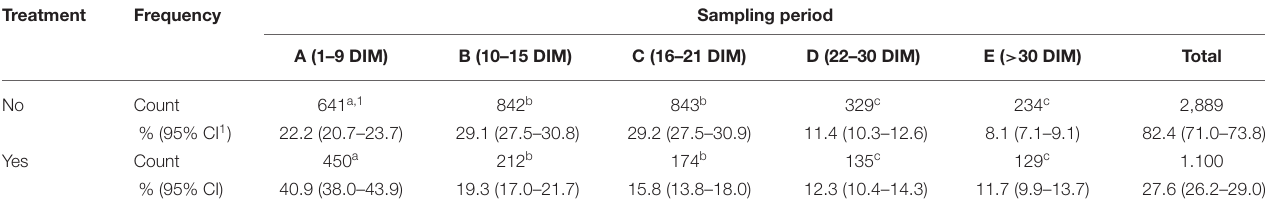
TABLE 5 | Percentage of treated cows during the five sampling periods.